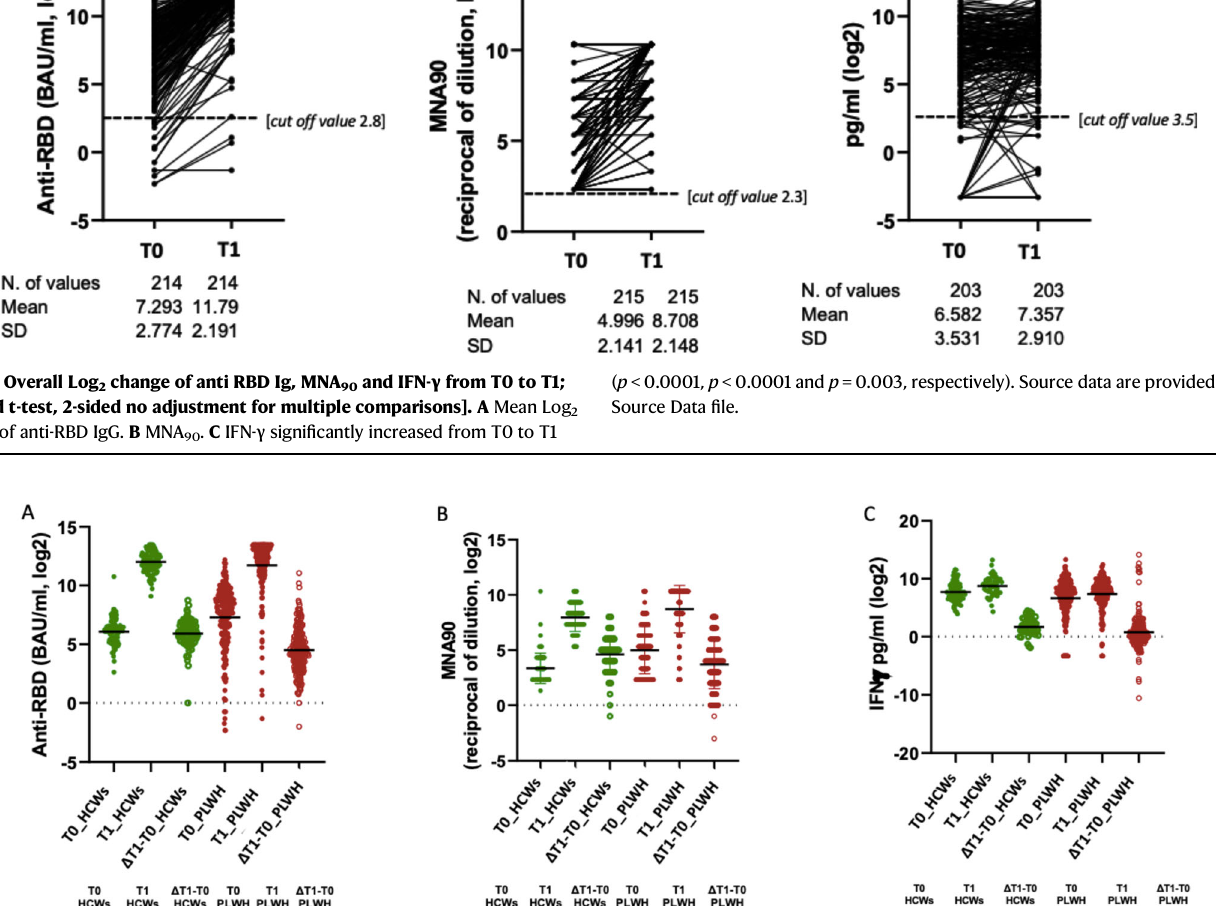
( p -values are Bonferroni-corrected values). Green circles represent mean values of anti-RBDIgG,MNA 90 0,andIFN- γ inHCWs,redcirclesrepresentmeanvaluesofanti RBDIgG,MNA 90 ,andIFN- γ inPLWH.SourcedataareprovidedasaSourceData fi le.